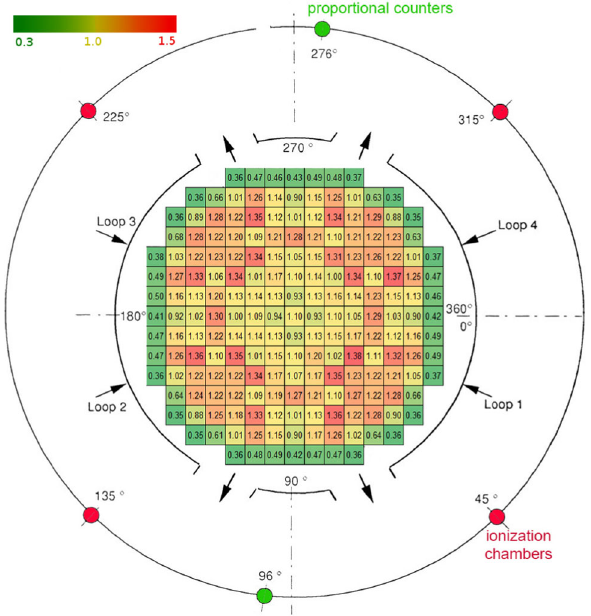
Fig. 5 Measured power density distribution using the in-core instru- mentation during December 2016. For each of the 193 fuel assemblies the relative contribution to the total thermal power is denoted. Green corresponds to a small contribution, red to a high contribution, yellow covers the regime